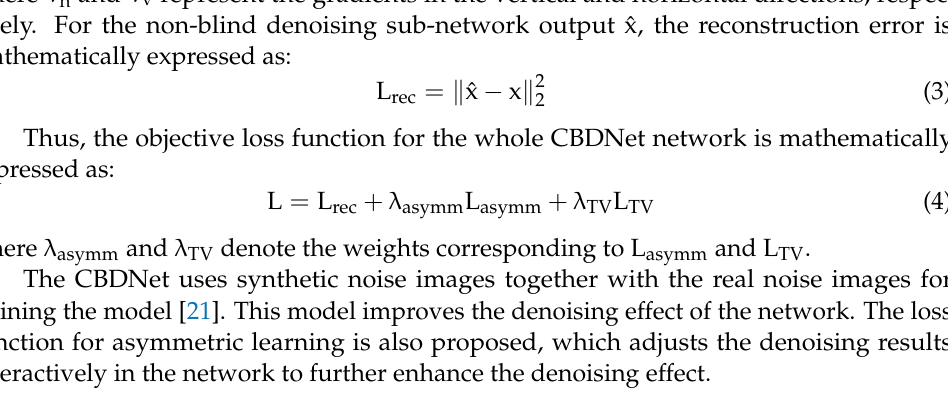
VGG19CBDNet Figure 3. The terahertz spectral image enhancement model for unsound kernels of wheat.